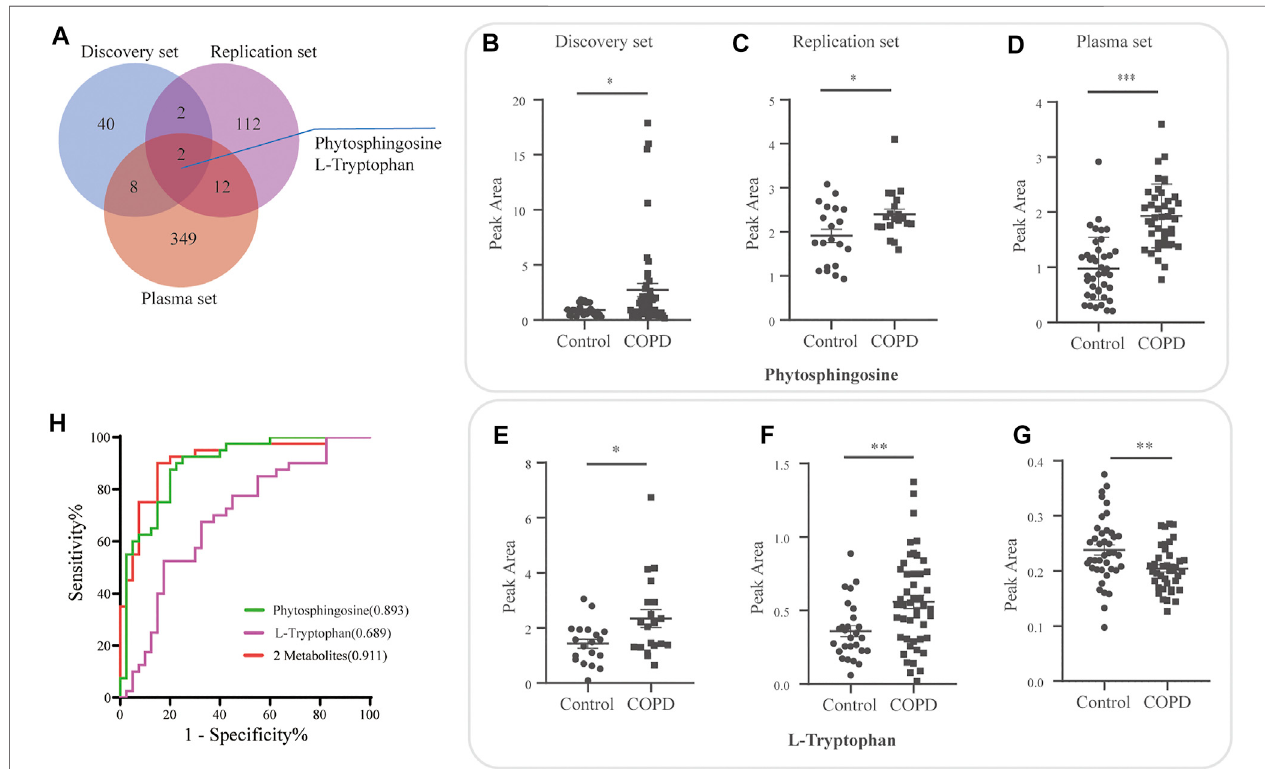
FIGURE 5 | Overlapping candidate metabolite biomarkers in three sets. (A) Venn diagram demonstrating overlap and unique differential metabolites for the discovery, plasma and replication sets. Relative expression of phytosphingosine (B – D) and L -tryptophan (E – G) in the discovery, plasma and replication sets. (H) Evaluation of the diagnostic value of the overlapping metabolites by logistic regression model, and receiver operating curve (ROC) analysis and area under the curve (AUC).